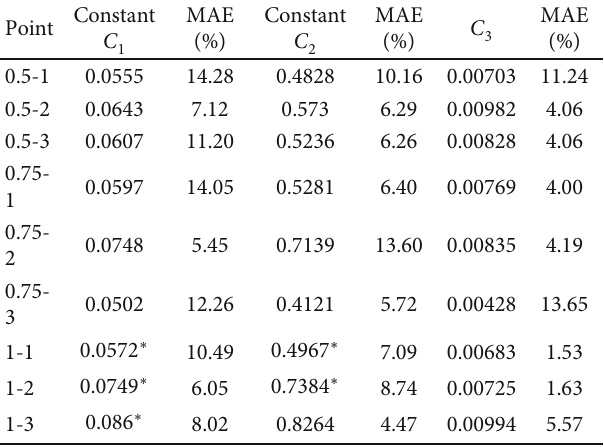
Table 4: Constants for every point in Equations (2), (3) and (11),